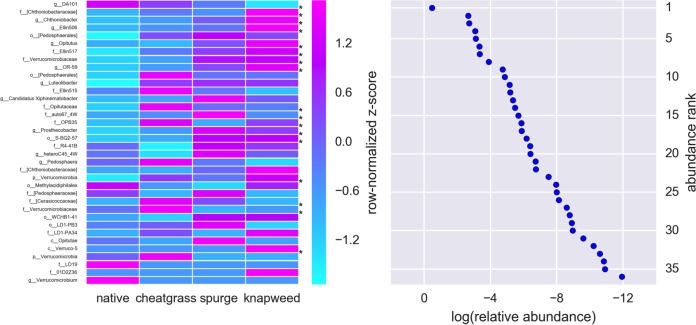
Differences in Verrucomicrobia genera across plant community types. The heatmap shows differences in the abundances of genera across plant communities (row-normalized z scores), where asterisks highlight significant differences (FDR-corrected P < 0.05). The plot to the right of the heatmap shows the rank-ordered abundance of each genus in the heatmap. The solid blue circles in the rank abundance plot are aligned with the genera identified in the heatmap.